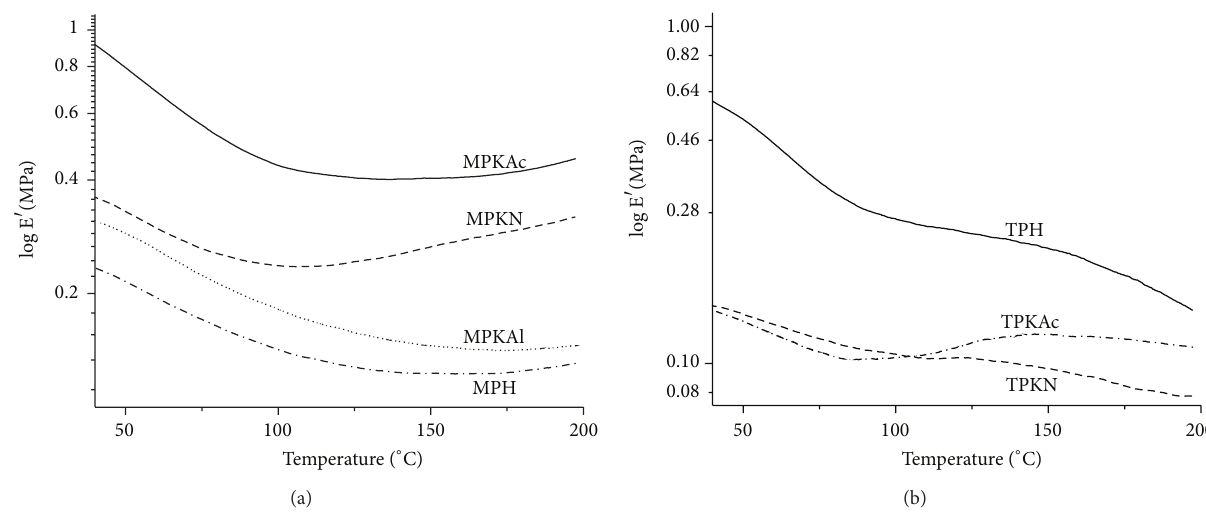
Figure 5: Storage modulus of PU-keratin membranes; (a) for MDI and (b) for